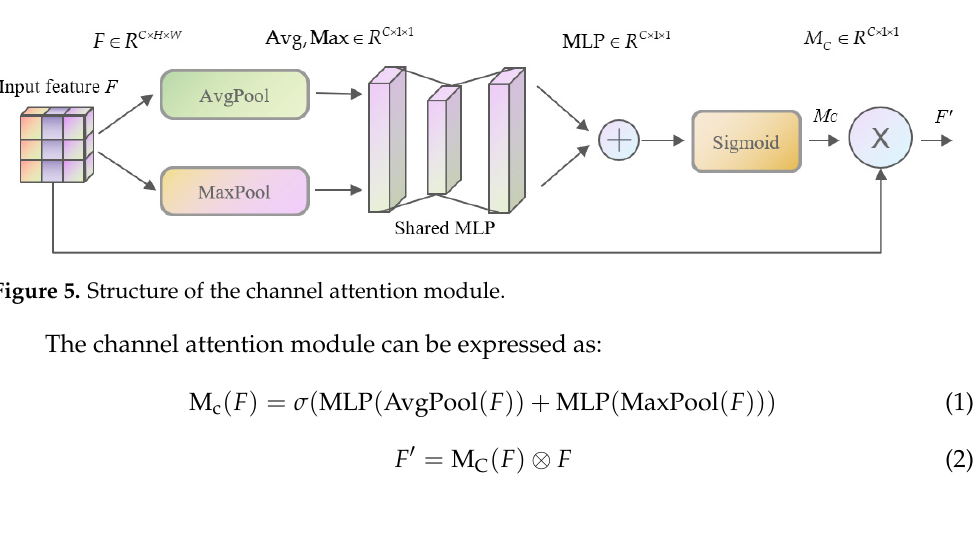
Figure 5. Structure of the channel attention module.